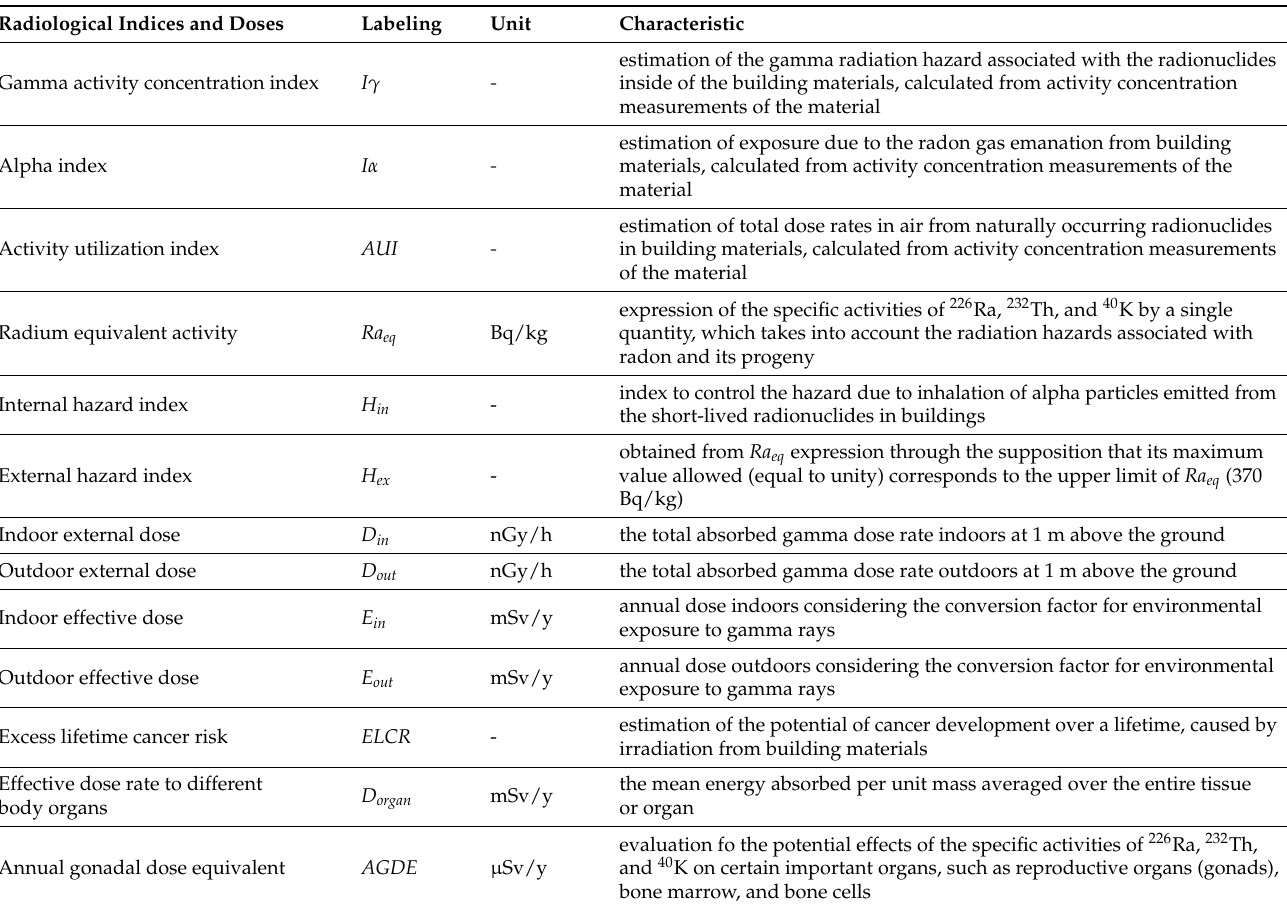
Table 2. Radiological parameters and their